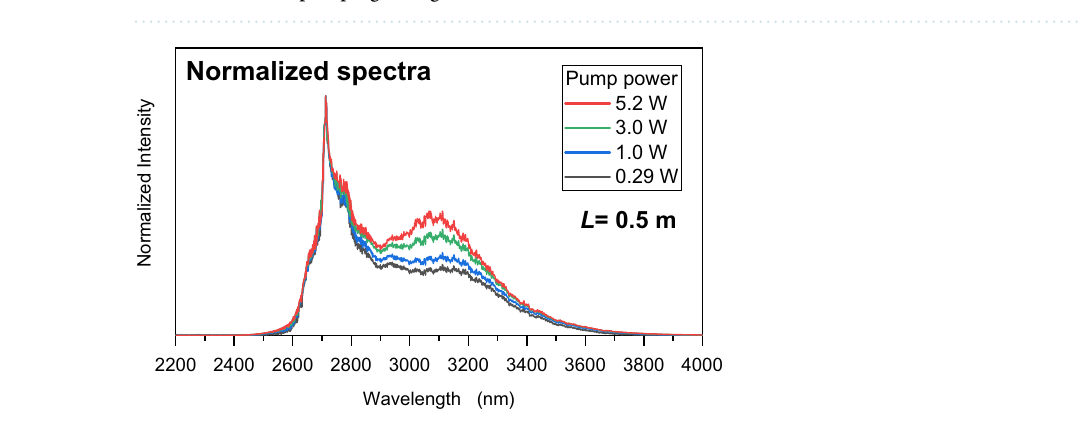
Figure 3. Normalized spectra of ASE from the co-doped ZBLAN fiber in ( a ) forward-pumping configuration and ( b ) backward-pumping configuration.